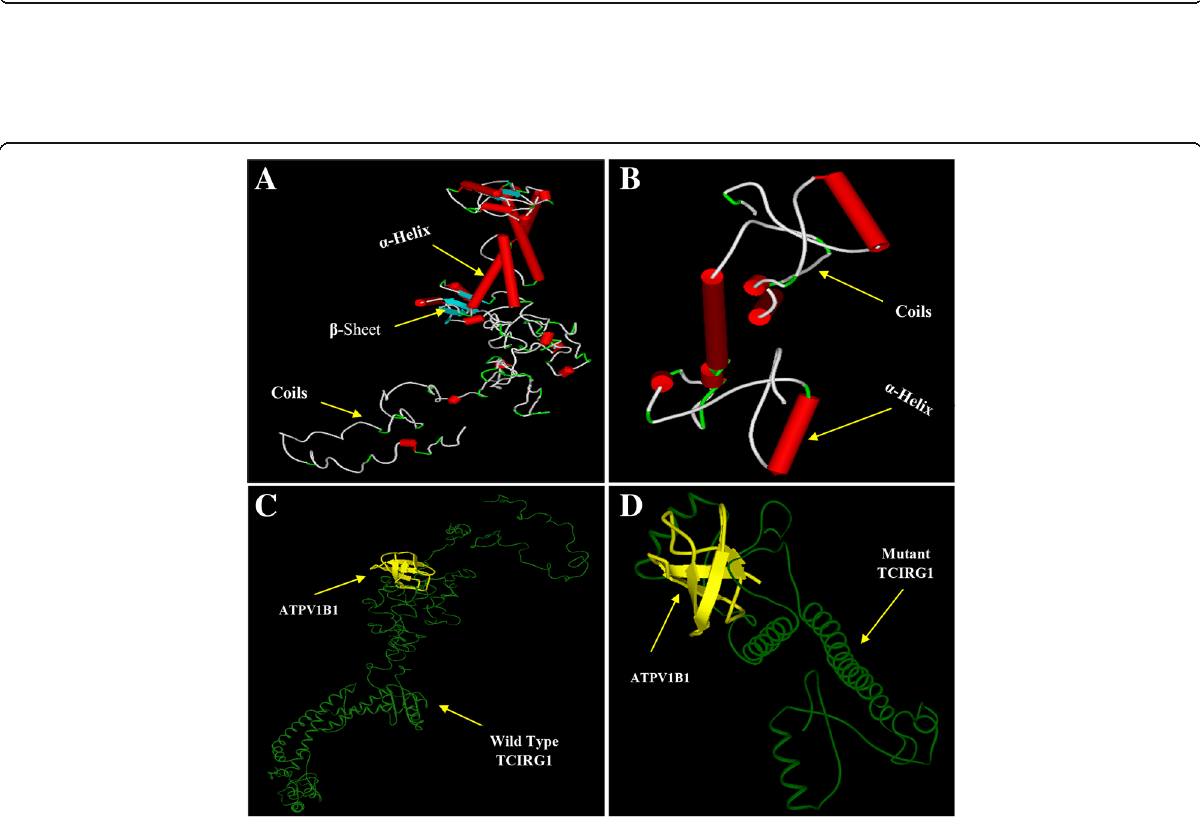
Fig. 4 3D – Models. a Normal TCIRG1 b Mutant TCIRG1 (p.P208PfsX1) . Docking complex visualization: c TCIRG1 vs ATPV1B1 d Mutant TCIRG1 vs ATPV1B1. Receptor protein has been shown in solid ribbon display style with green color; ligand has been shown in secondary type with yellow color